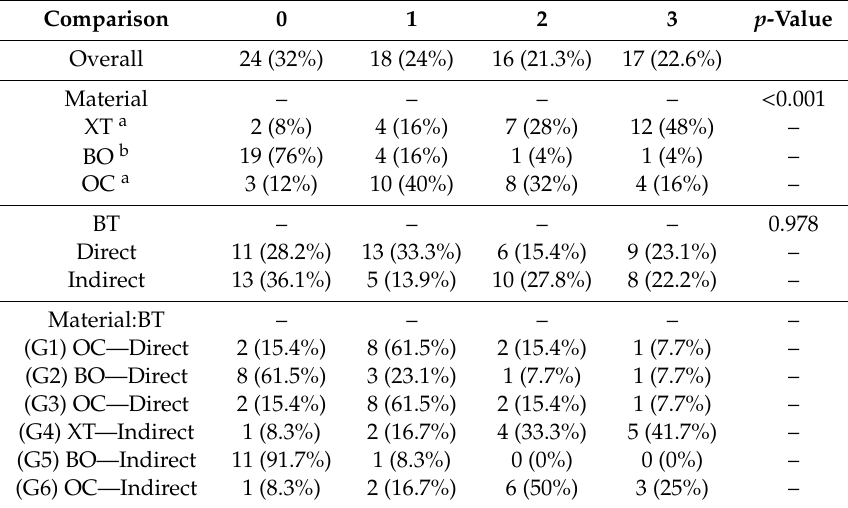
Table 5. Frequency and percentage for overall sample, two factors, and six groups.